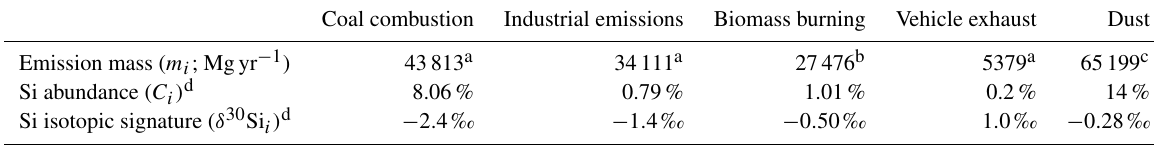
Table 1. Parameters for primary sources used in the estimation of secondary aerosol contribution to PM 2 . 5 . Coal combustion Industrial emissions Biomass burning Vehicle exhaust Dust Emission mass ( m i ; Mgyr − 1